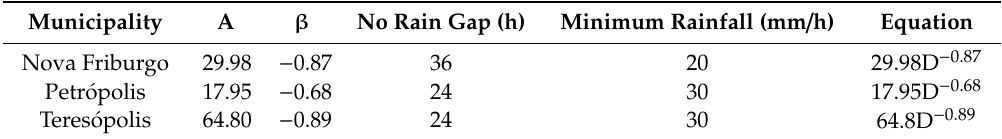
Table 2. Thresholds equations and